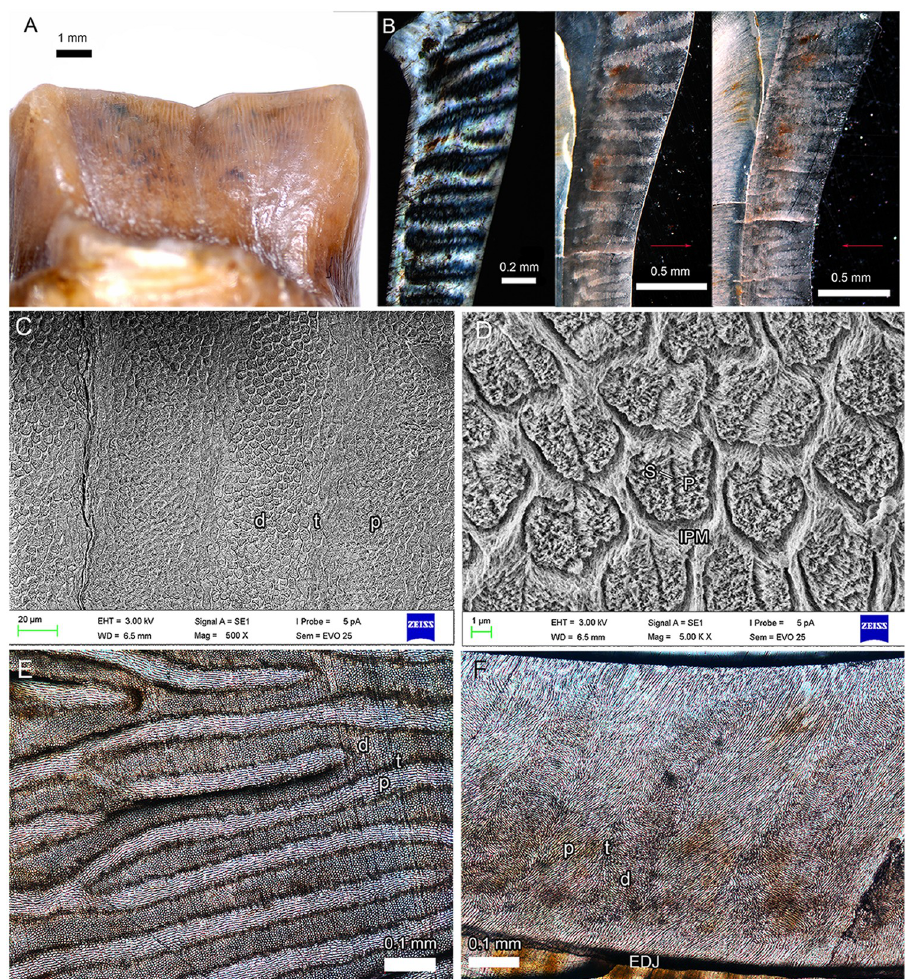
Fig 6. Enamel microstructure of the second lower molar of deperetellid Irenolophus sp. (IVPP V 25832). (A) vertical Hunter-Schreger Bands (HSB) in anterior view of the protolophid. (B) vertical HSB in the cross sections with polarized light and ordinary light; arrows showing the ordinary light directions. (C) vertical HSB and transitional zones in cross section. (D) prism shape in cross section. (E) parazone, diazone, and transitional zones in the tangential section. (F) Schmelzmuster in the vertical section. Abbreviations: d, diazone; EDJ, enamel-dentine junction; IPM, interprismatic matrix; P, prism; p, parazone; S, seam; and t, transitional zone.